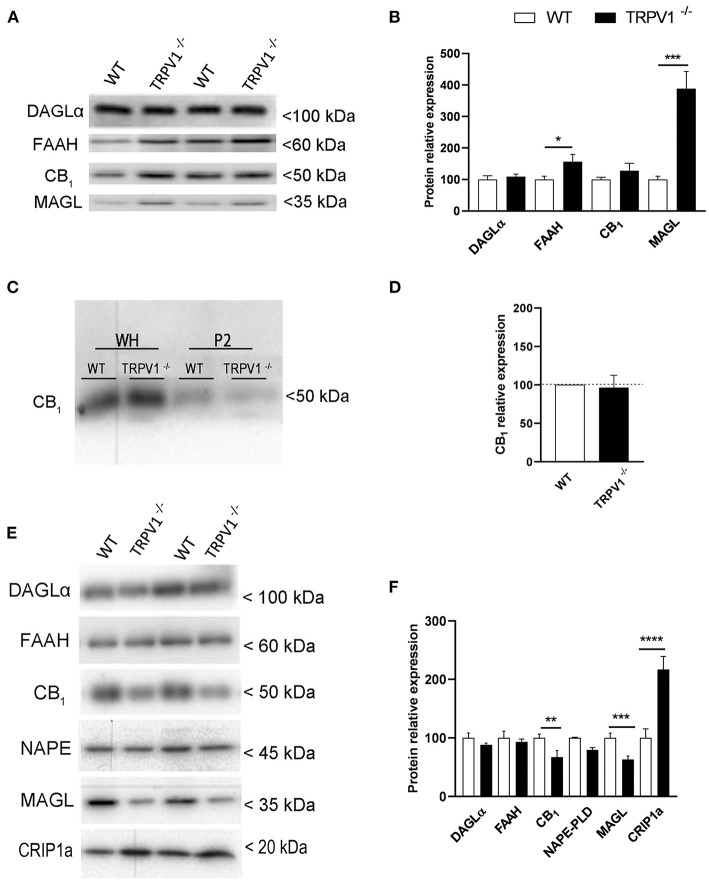
(A,B) Immunoblot and relative expression of CB1R and endocannabinoid enzymes in hippocampal whole homogenates from WT and TRPV1−/− mice. MAGL and FAAH increase significantly in TRPV1−/−. Data were analyzed by means of non-parametric or parametric tests (Mann–Whitney U-test or Student's t-test). (C) Immunoblot of CB1R in whole homogenates and P2 extracts of raw membranes from WT and TRPV1−/− mice hippocampi. (D) Relative expression of CB1R in P2 extracts from WT and TRPV1−/−. Not significant changes are detected in TRPV1−/−. Student's t-test. (E,F) Immunoblot and relative expression of CB1R, endocannabinoid enzymes, and CB1R interacting protein 1a in hippocampal synaptosomes from WT and TRPV1−/− mice. CB1R and MAGL decrease but CRIP1a increases significantly in TRPV1−/−. Fisher's exact test. p > 0.05; p < 0.05*; p <0.005**; p< 0.001***. Data are expressed as mean ± S.E.M.